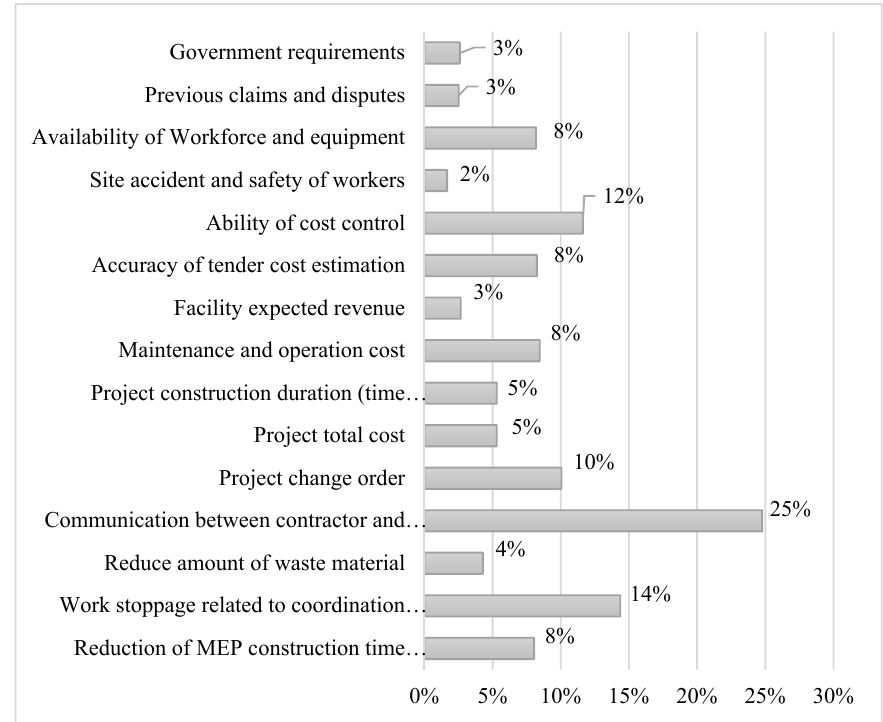
Figure 7. BIM impact on survey criteria.